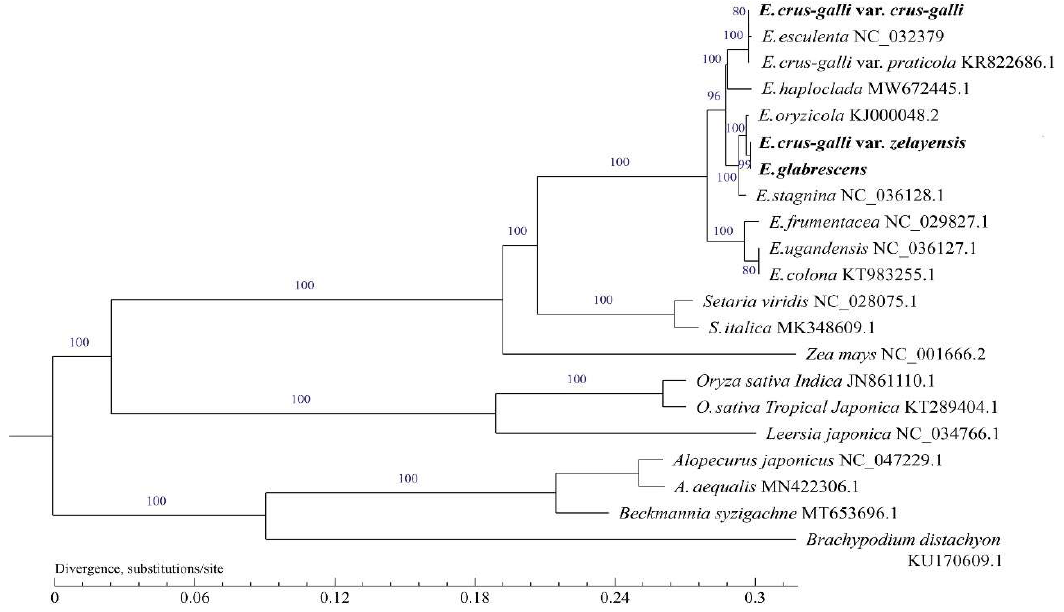
Figure 6. Phylogenetic tree for 20 species of Gramineae using maximum likelihood, based on alignments of complete chloroplast genomes. The numbers at the nodes indicate bootstrap values from 1000 replicates. If the bootstrap values are 100, this number was not shown on the nodes. The species in bold font were sequenced in this study.